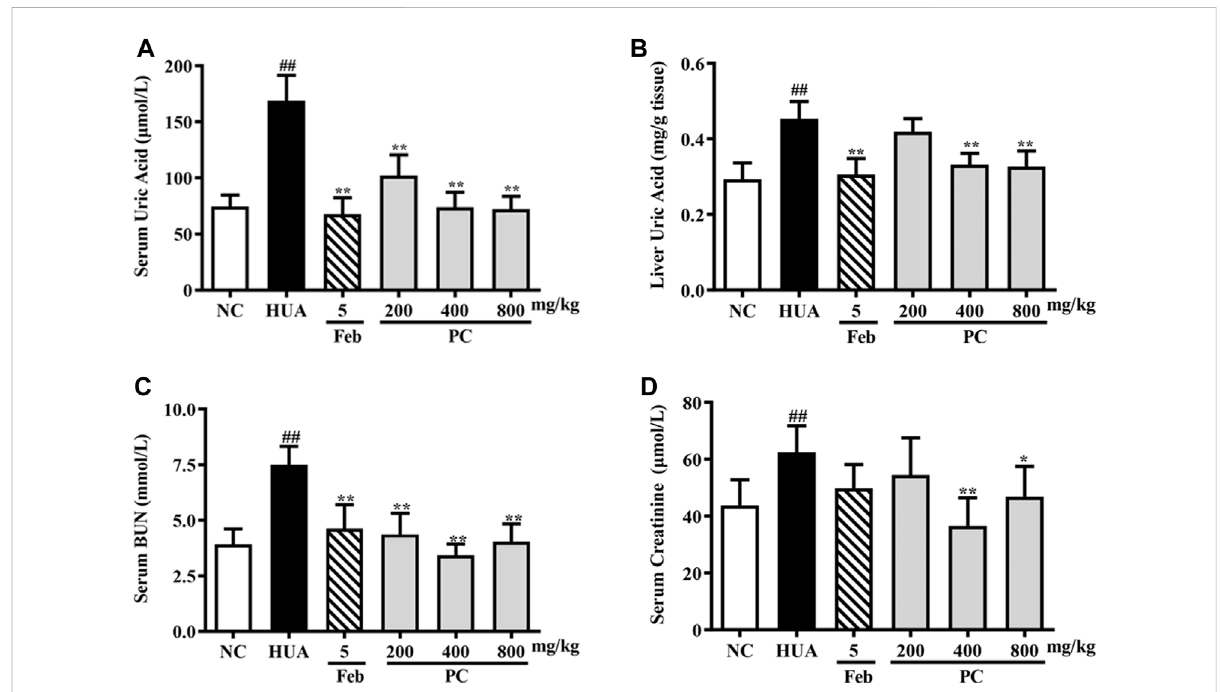
FIGURE 7 EffectsofCPonliverUA,serumUA,Cre,andBUNlevelsinPO/HX-inducedHUAmice. (A) TheserumlevelofUA. (B) TheliverlevelofUA. (C) The serumlevelofBUN. (D) TheserumlevelofCre.Theresultsareexpressedasmean±SD( n =10). ## p < 0.01comparedwithNCgroup;* p < 0.05,** p < 0.01 compared with HUA